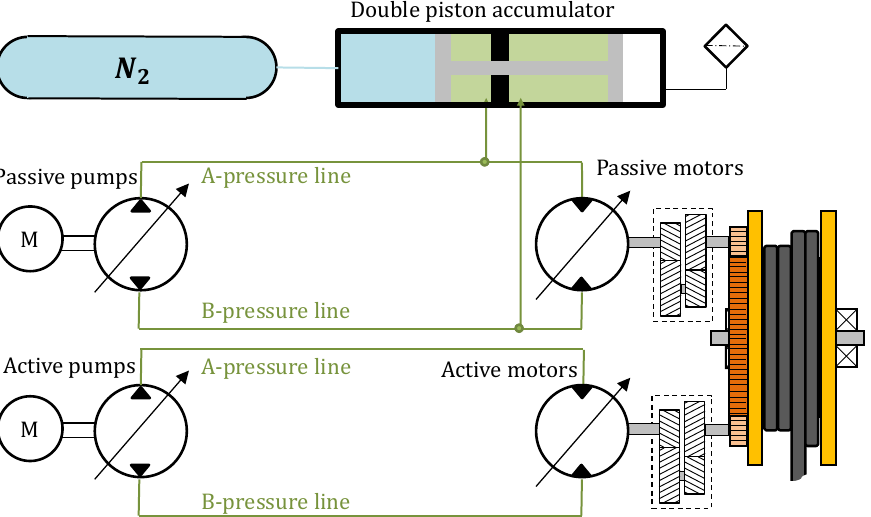
Figure 1. Simplified schematic for a hydraulic active/passive winch